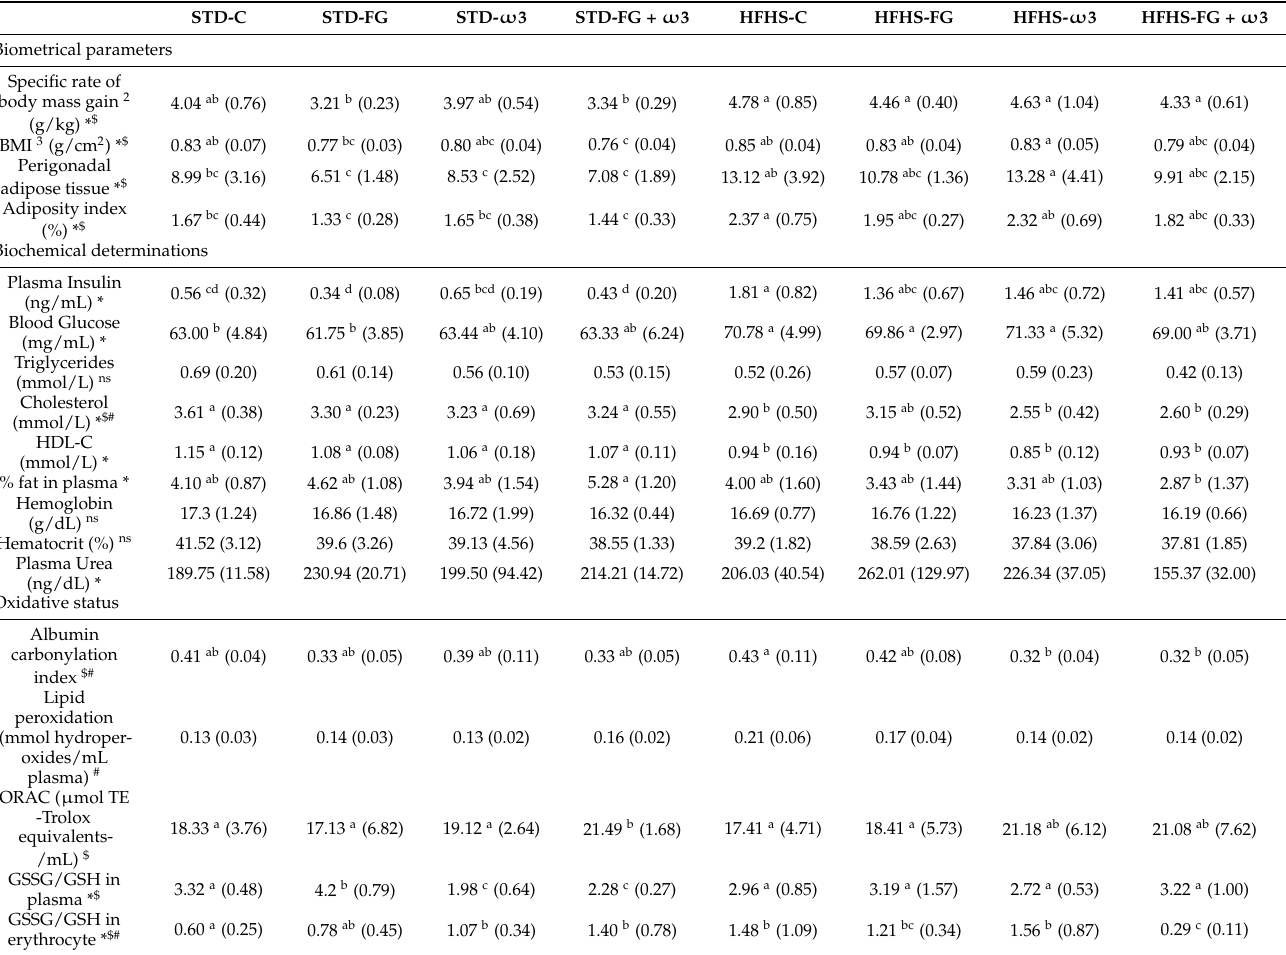
Table 1. General biometrical and biochemical determinations and whole-body oxidative status evaluation of Sprague Dawley rats fed the different experimental diets and supplements 1